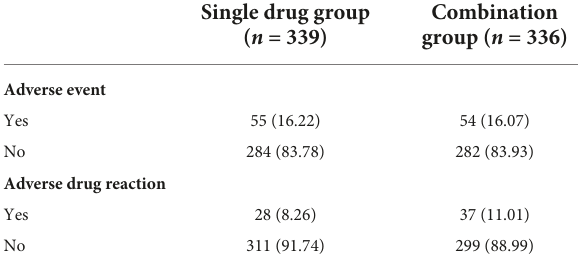
TABLE 4 Rates of adverse events and adverse drug reactions in patients with generalized anxiety disorder treated with Jiuwei Zhenxin granules alone (single drug group) or in combination with alprazolam (combination group). Single drug group ( n =